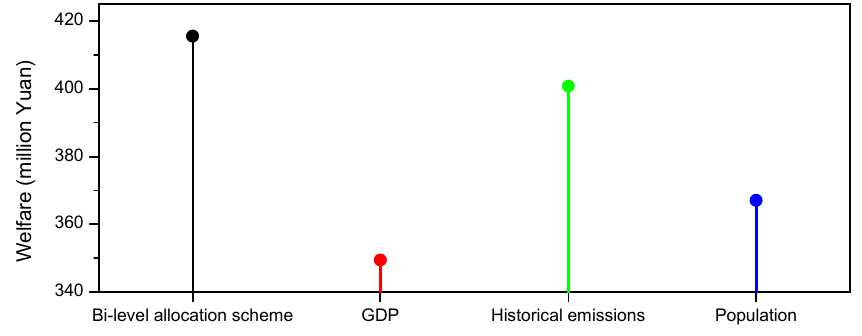
Figure 10. Total welfares of different quota allocation schemes under target 2.